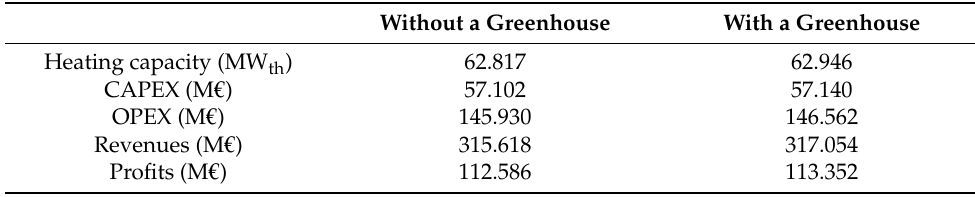
Table 3. Main outputs of the optimization model for the Herstal case